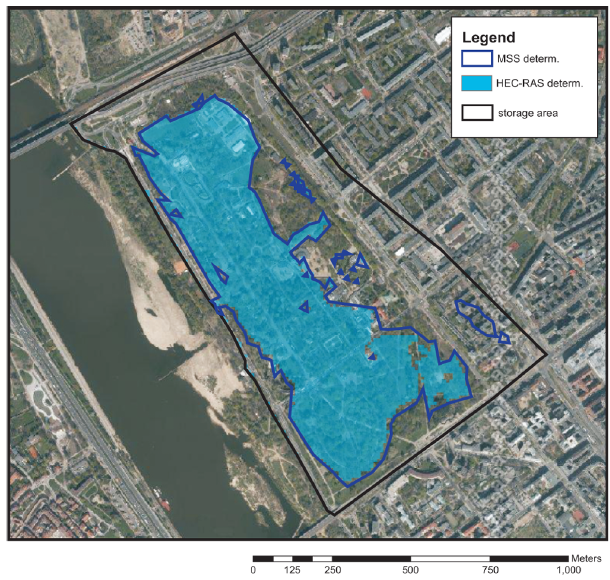
Fig. 5. Comparison of MSS and HEC-RAS unsteady flow inunda- tion area for